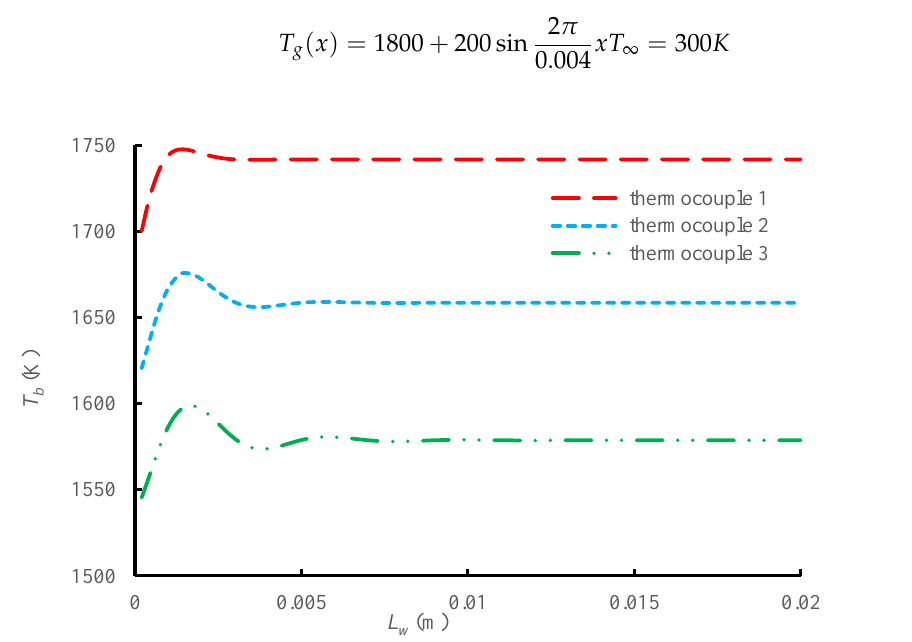
Figure 5. Thermocouple bead temperature variation with L w.